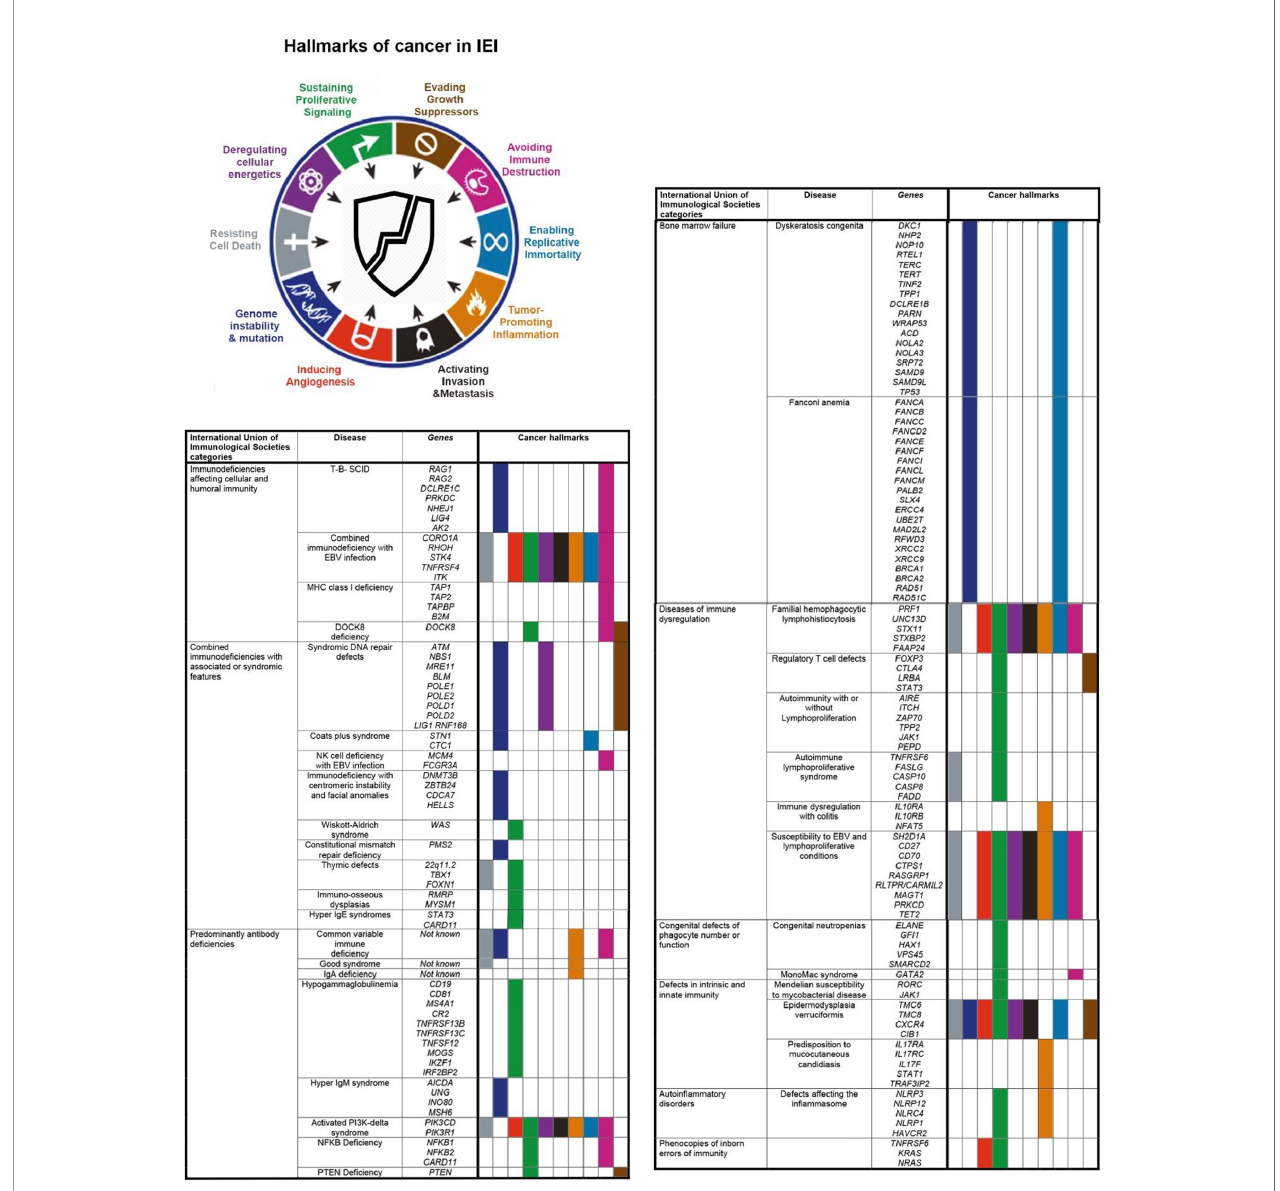
FIGURE 1 | Cancer hallmark activation in different types of monogenic inborn errors of immunity (IEI) according to the International Union of Immunological Societies classi fi cation (1,